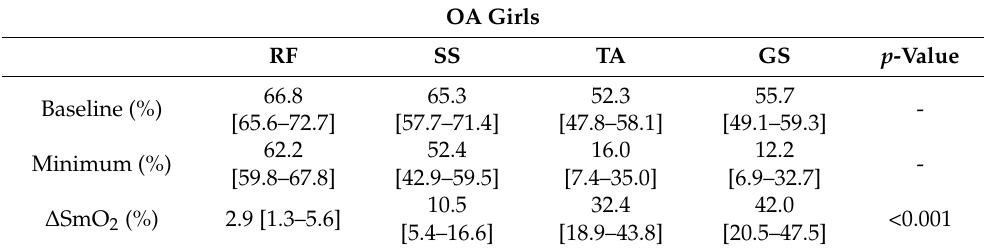
Table 3. The physiological cost index values for the four groups.